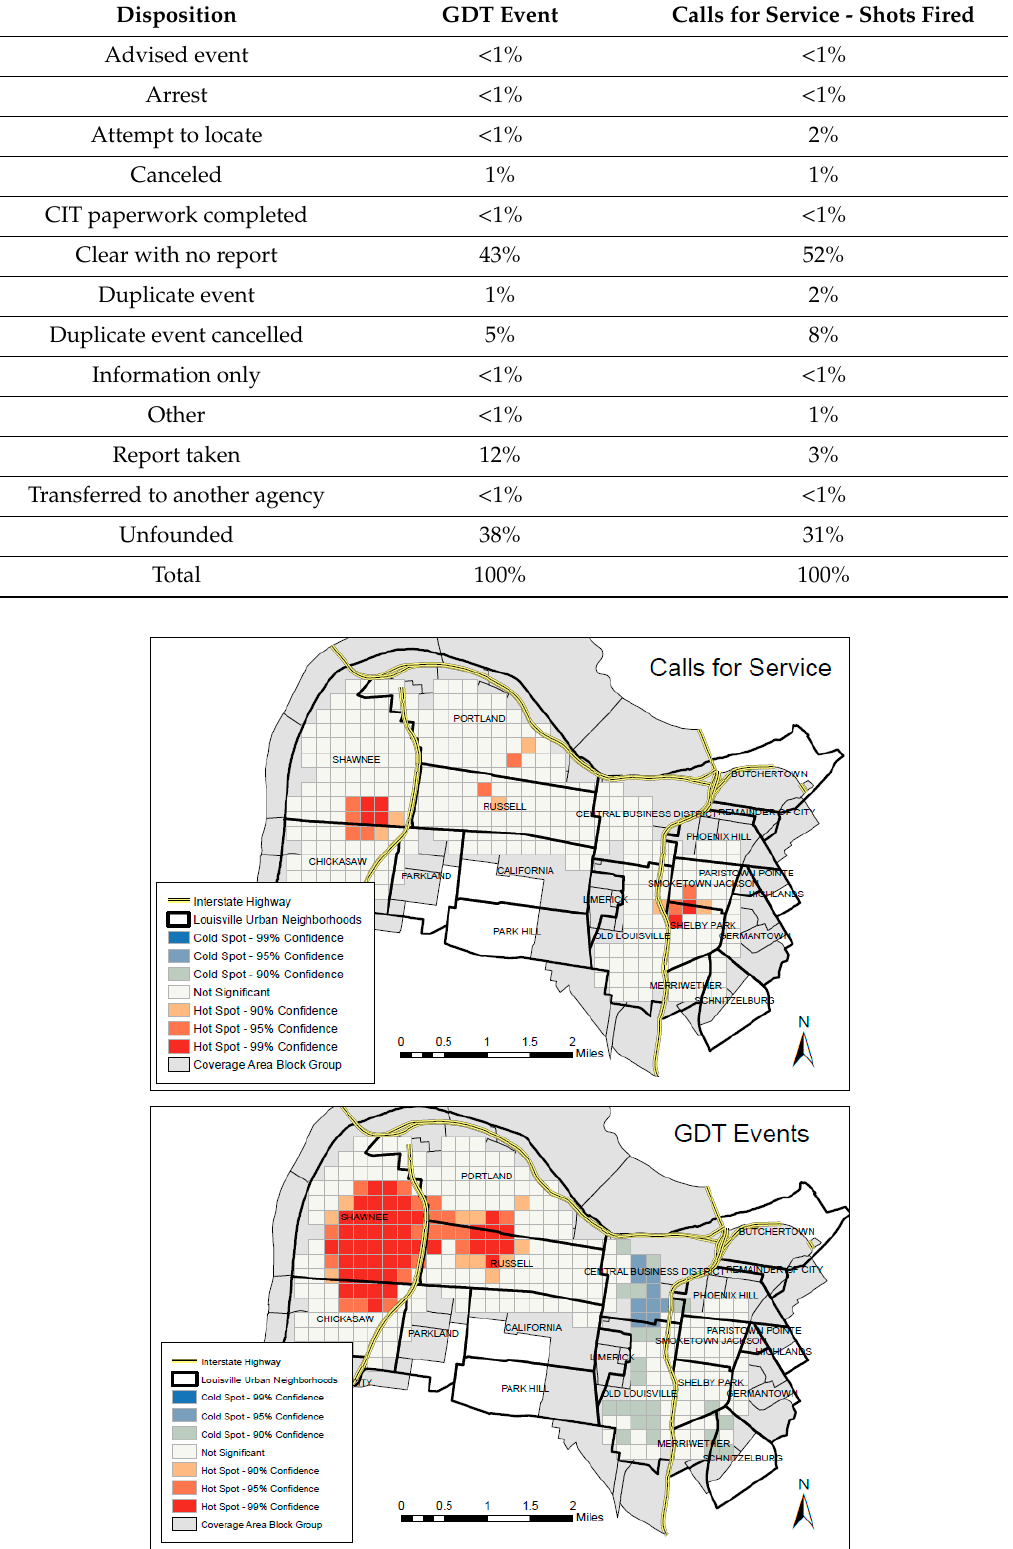
Table 2. Disposition for all GDT events and calls for service in Louisville, KY.